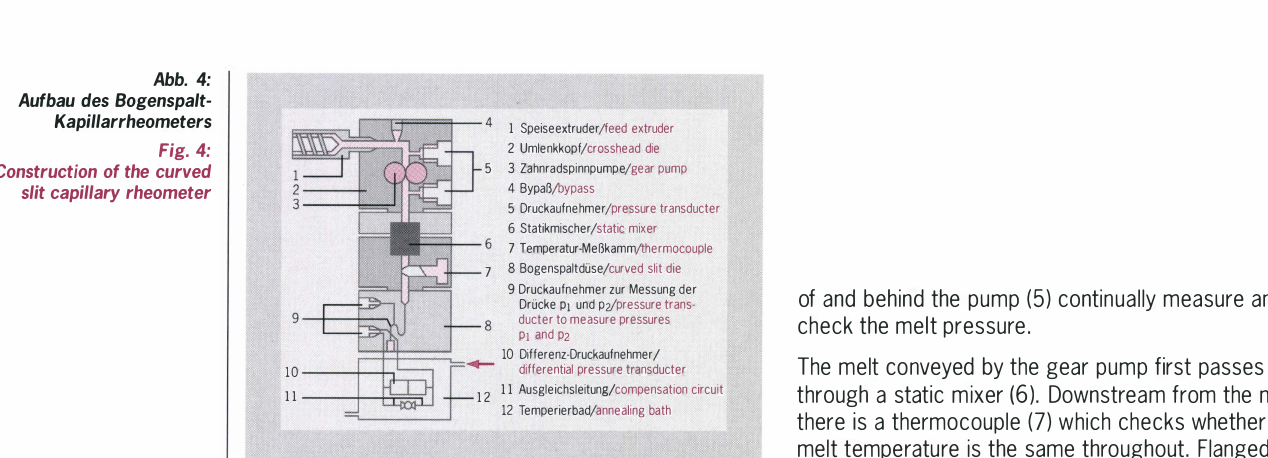
Fig. 4: Construction of the curved slit capillary